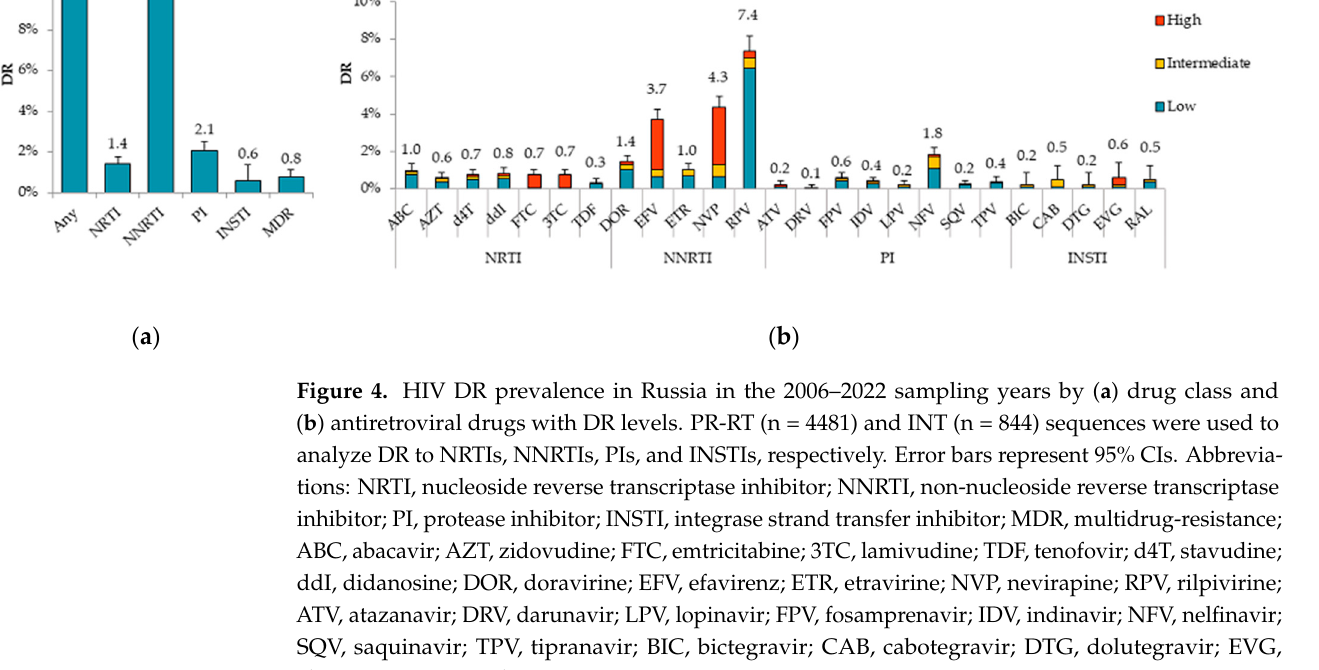
elvitegravir; RAL, raltegravir.